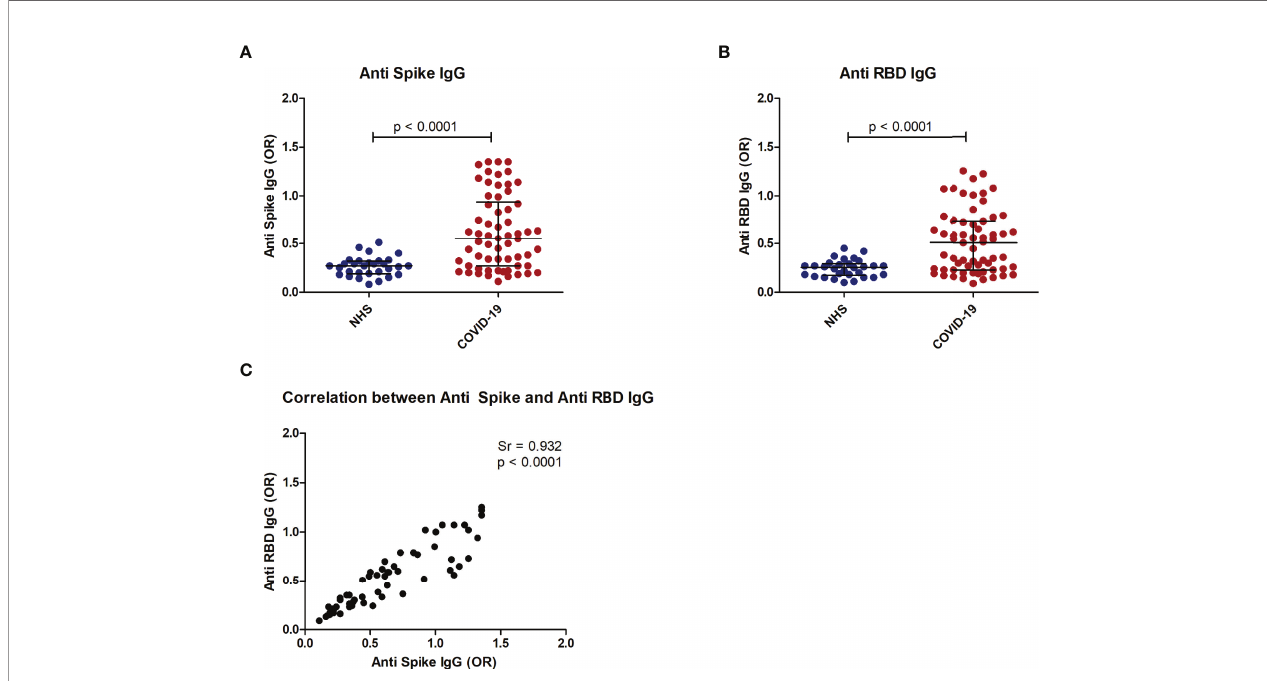
FIGURE 5 | Anti-Spike and anti-RBD antibodies in COVID-19 patients. Distribution of anti-S IgG (A) and anti RBD IgG (B) in COVID-19 patients as compared to normal controls (NHS). Correlation of anti-S IgG and anti-RBD IgG in COVID-19 patients (C) . p < 0.05 was considered signi fi